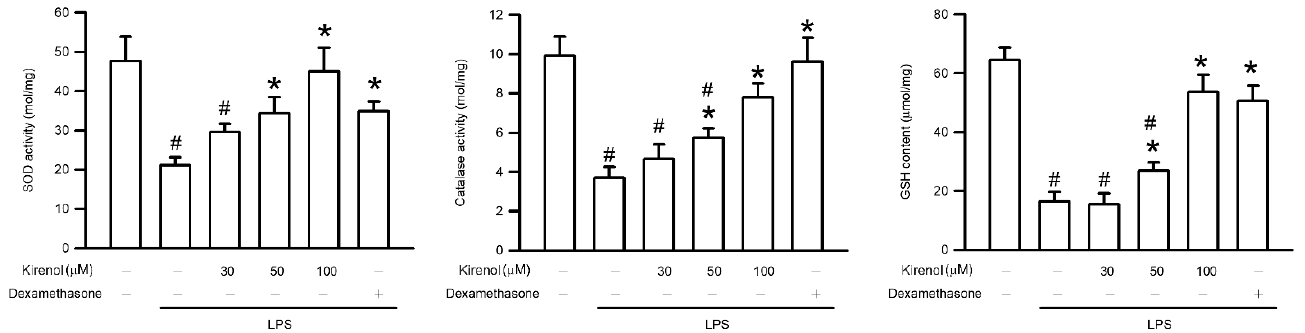
Figure 6. Kirenol attenuated the LPS-reduced the activities of superoxide dismutase (SOD), catalase, GPx. Values are shown the mean ± S.D. of 3–4 mice per group. # represents the significant difference compared with the Group I ( p < 0.05); * represents the significant difference compared with the Group II ( p < 0.05).